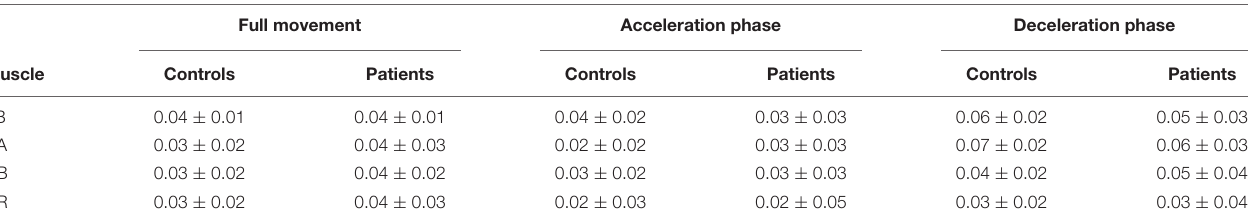
TABLE 2 | Average CMC magnitude ± SE of each group in all muscles and all movement phases. Full movement Acceleration phase Deceleration phase Muscle Controls Patients Controls Patients Controls